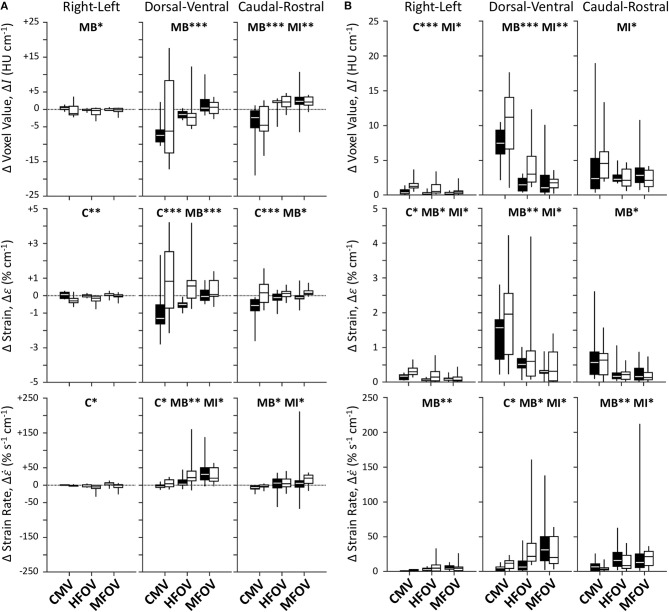
Unnormalized spatial gradient values (A) and magnitudes (B) for image registration-based regional ventilation measures of intratidal changes in aeration (ΔI), volumetric strain (Δε), and volumetric strain rate (Δε˙). Linear spatial gradients in each of the three principal anatomic directions throughout the lung mask are shown for each variable, represented by box plots showing minimum, maximum, and quartiles across subjects under baseline (black) and injured (white) conditions, during conventional mechanical ventilation (CMV), high-frequency oscillatory ventilation (HFOV), and multi-frequency oscillatory ventilation (MFOV). Asterisks indicate significance levels (*p < 0.05, **p < 0.01, ***p < 0.001) for main effects (C = lung condition, MB = modality for baseline condition, MI = modality for injured condition). See Table 2 for additional clarification.